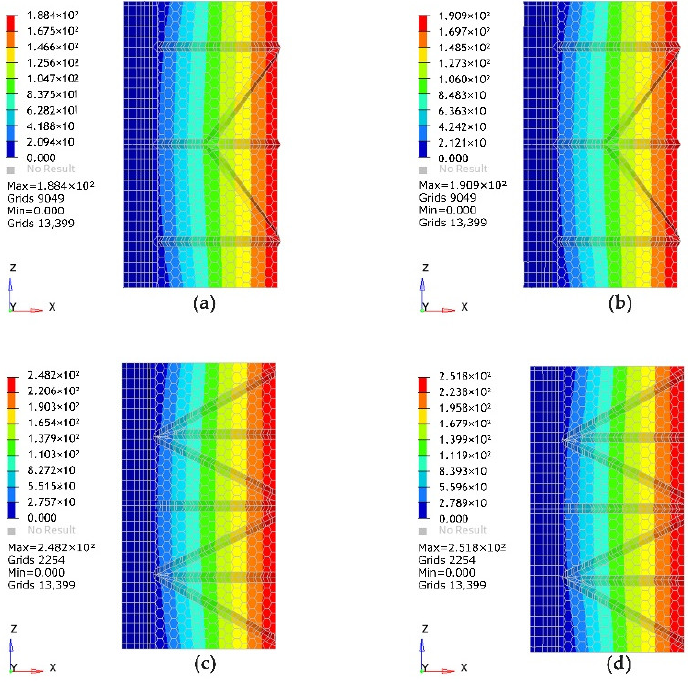
Figure 16. ( a ) Linear combined displacement analysis of carport I model under the load of 1.2 G K + 1.4 Q W ; ( b ) Nonlinear combined displacement analysis of carport I model under the load of 1.2 G K + 1.4 Q W ; ( c ) Linear combined displacement analysis of carport II model under the load of 1.2 G K + 1.4 Q W ; ( d ) Nonlinear combined displacement analysis of carport II model under the load of 1.2 G K + 1.4 Q W .